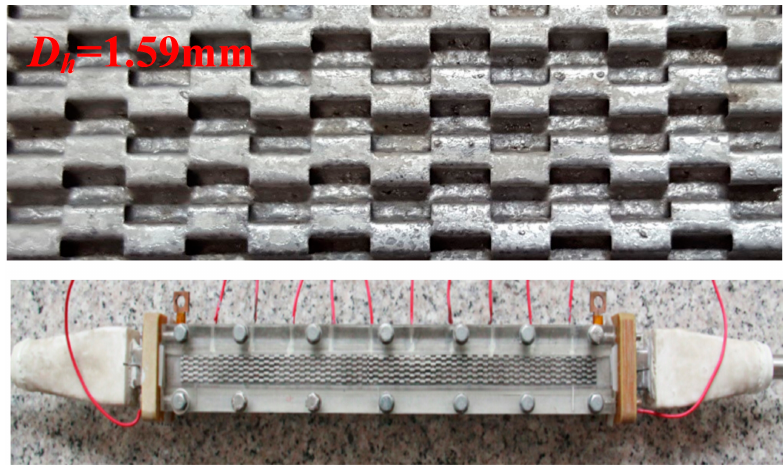
Figure 2. Real picture of the tested mini channel and test